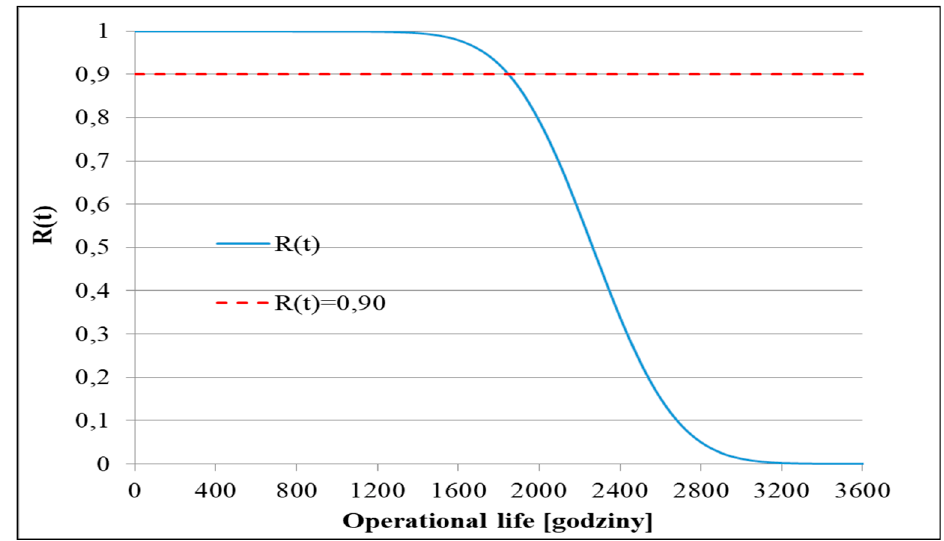
Figure 7. Reliability of brushes of the 200SGL129Q starter-generator No. 8544XL.